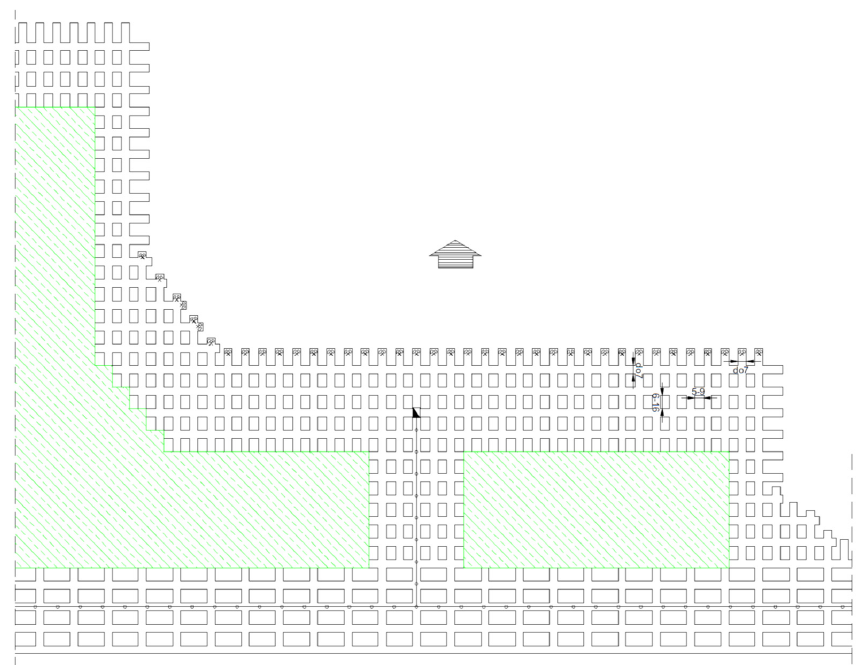
Figure 3. Room and pillar mining system with closing pillar J-UGR-PS [42].